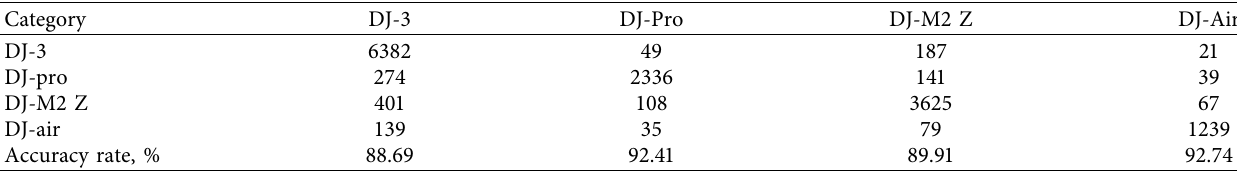
Table 2: Confusion matrix of YOLOv3 classification results.